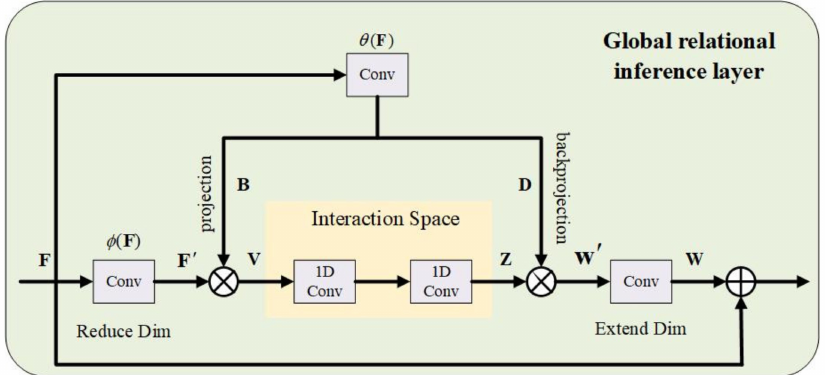
Figure 4. Global relational inference layer. Two convolutions are for dimension reduction and expansion. Projection matrix B and back projection matrix D transpose each other. They can be obtained by a convolution operation. The graph interaction has two 1D convolutions, one along the channel direction and the other along the node direction.